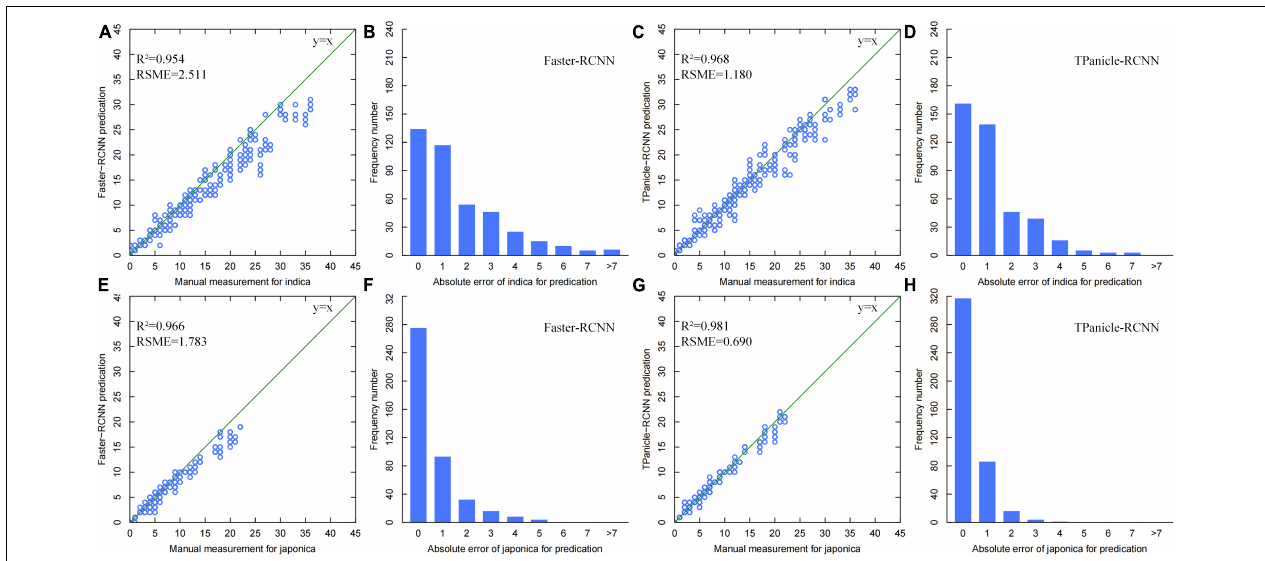
FIGURE 8 | (A,B) Threshed panicle spikelet number scatter plots of manual versus model measurement and error distribution diagrams for indica rice samples with Faster-RCNN measurement (Brichet et al., 2017), TPanicle-RCNN measurement (C,D) , and japonica rice samples with Faster-RCNN measurement (E,F) , TPanicle-RCNN measurement (G,H)